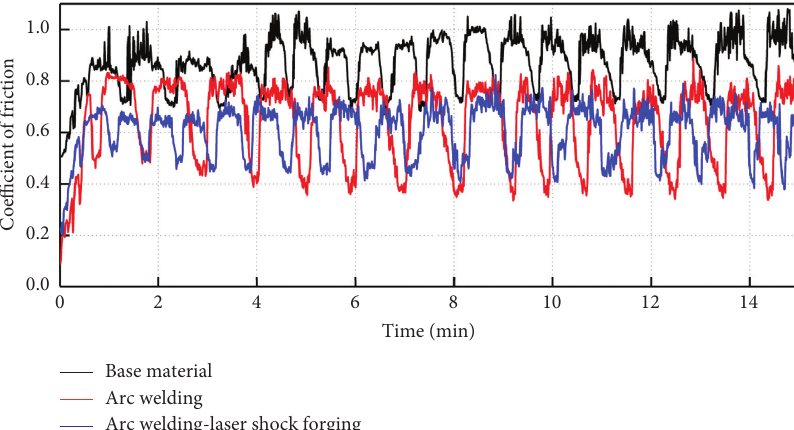
Figure 8: Evolution of friction coefficient of the BM, AW cladded layer, and AW-LSF cladded layer as a function of wear time.